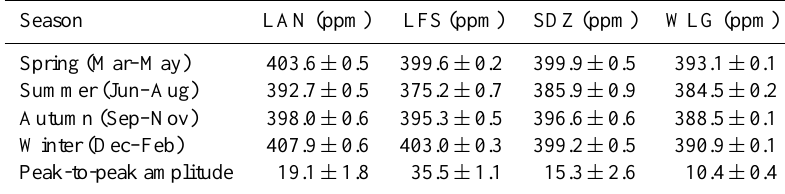
Table 2. Seasonal average CO 2 concentration and amplitude from the regional or background data sets.